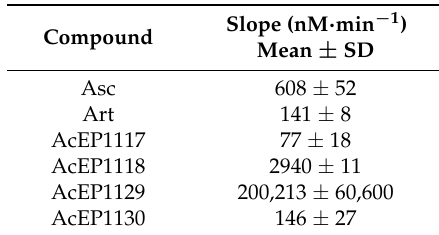
Table 2. Reaction of AcEPs and other EPs with Fe 2+ . The compounds (50 µM) were incubated with 250 µM FeSO 4 in the presence of 125 µM xylenol orange (XO) in a mixture of methanol/H 2 O (9:1 v / v ). The formation of the XO/Fe 3+ complex was monitored by measuring the OD at 560 nm vs. 650 nm over time. Data represent mean ± SD ( n = 3).